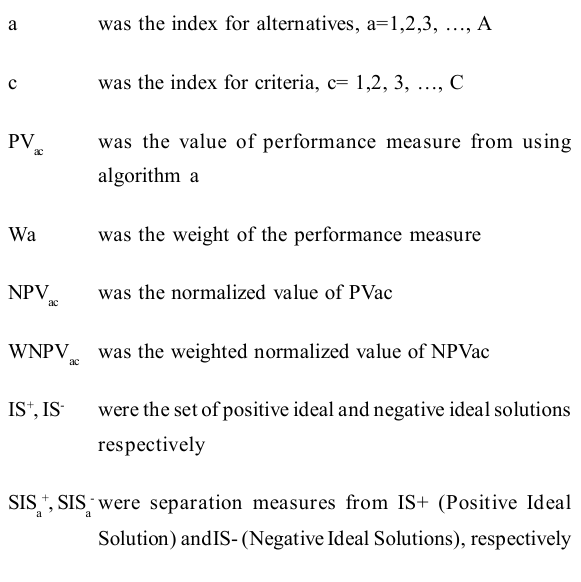
TABLE 4. WEIGHTED NORMALIZED VALUE OF PERFORMANCE MEASURES